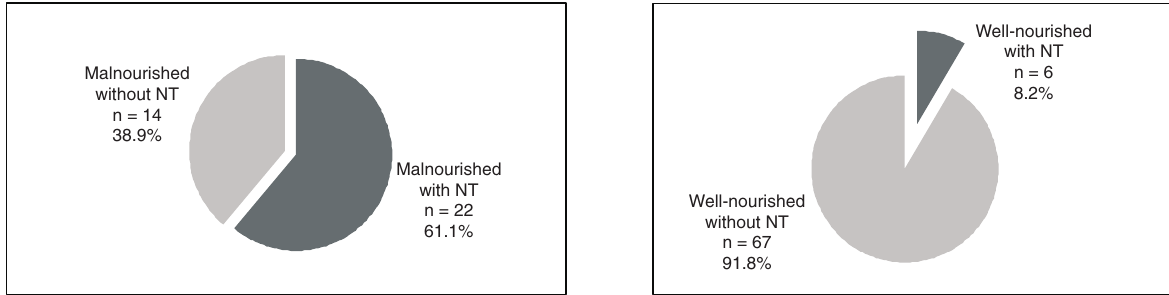
Figure 1. Administration of Nutritional Therapy (NT) as a function of nutritional status. Nutritional status was assessed by Subjective Global Assessment (SGA) within the first 48 h of hospitalization. SGA A = well-nourished; SGA B + SGA C = malnourished. Data are reported as number of patients.